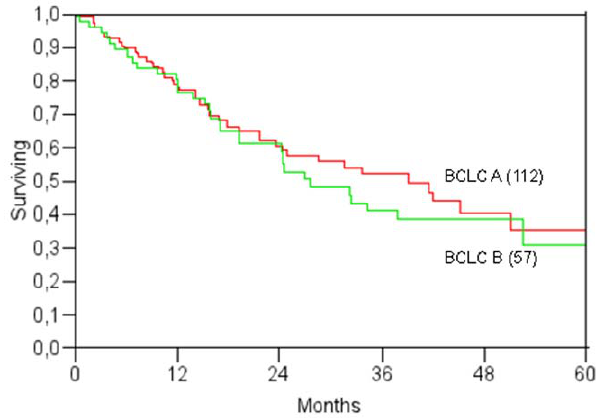
Figure 4. Survival according to possibility to have liver transplantation after LA